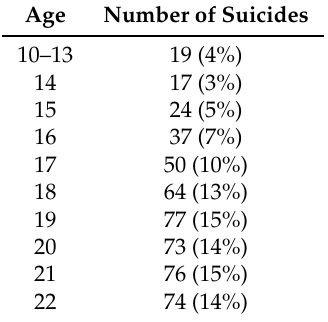
Table 3. Number of suicides by age of youths under 23 in the period 2013–2017 (percentage of total under 23 in brackets).